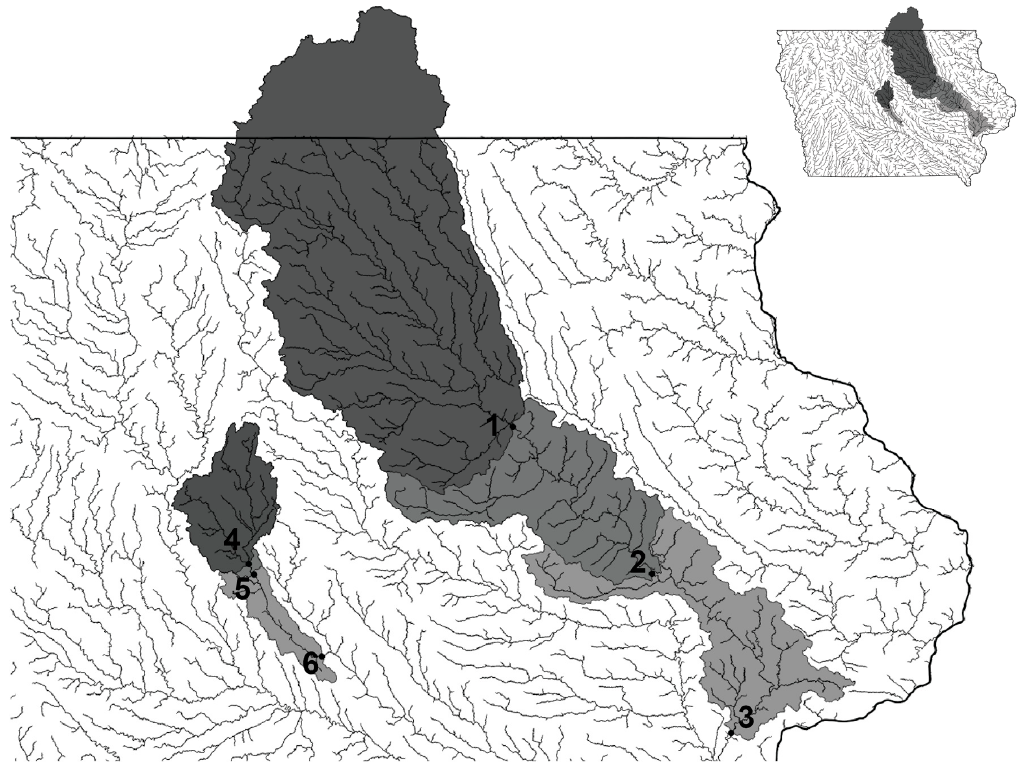
Figure 1. Cedar River Basin (larger area on the right) and South Skunk River Basin (smaller area on the left) watershed locations used for this study.